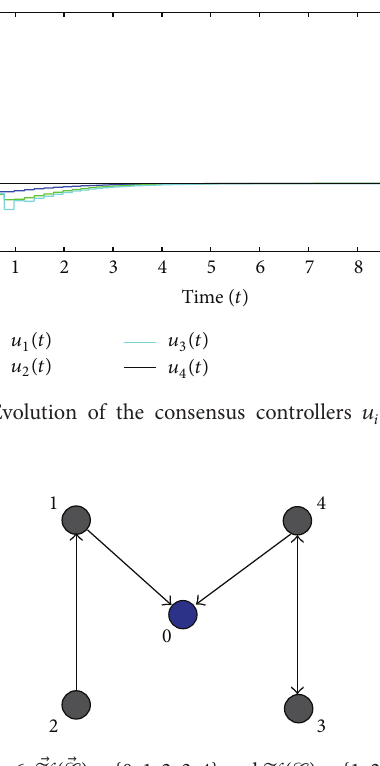
and V ( G ) = {1,2,3,4} .